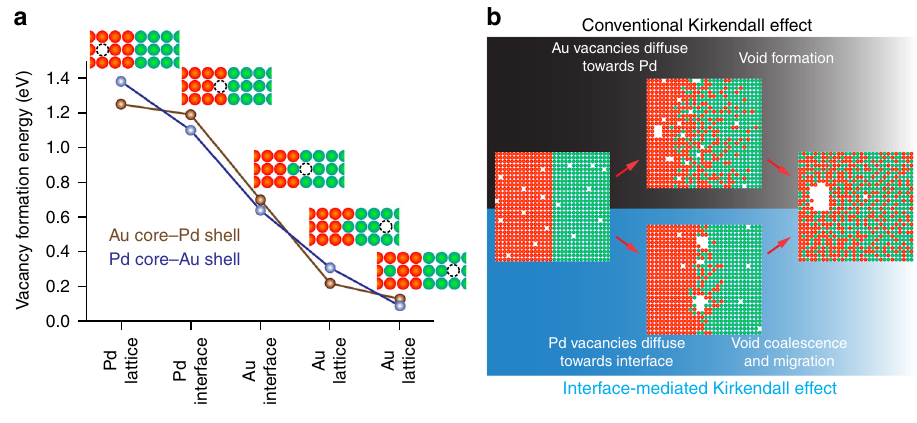
Fig. 3 Formation energy of Pd vacancies and a schematic illustrating interface-mediated Kirkendall effect (KE). a Density functional theory (DFT) calculations of the formation energy of a Pd vacancy at different locations of the Au – Pd layered structure (Supplementary Fig. 11). Migration of the Pd vacancy across the Au – Pd interface is accompanied by diffusion of a Au atom into a Pd lattice site. b A schematic comparison of the conventional KE and the observations of interfacial void formation and void migration in this study. The conventional view for KE is that interdiffusion leads to a fl ux of vacancies towards the faster-diffusing side. When the vacancy concentration in the diffusion zone reaches supersaturation, the vacancies can condense at defect sinks on the faster-diffusing side to form voids that grow with time 12,36 . In our study, we see void formation at the bimetallic interface due to the clustering of vacancies at the interface leading to void formation and subsequent void migration to the surface. Green and red spheres represent Au and Pd atoms,